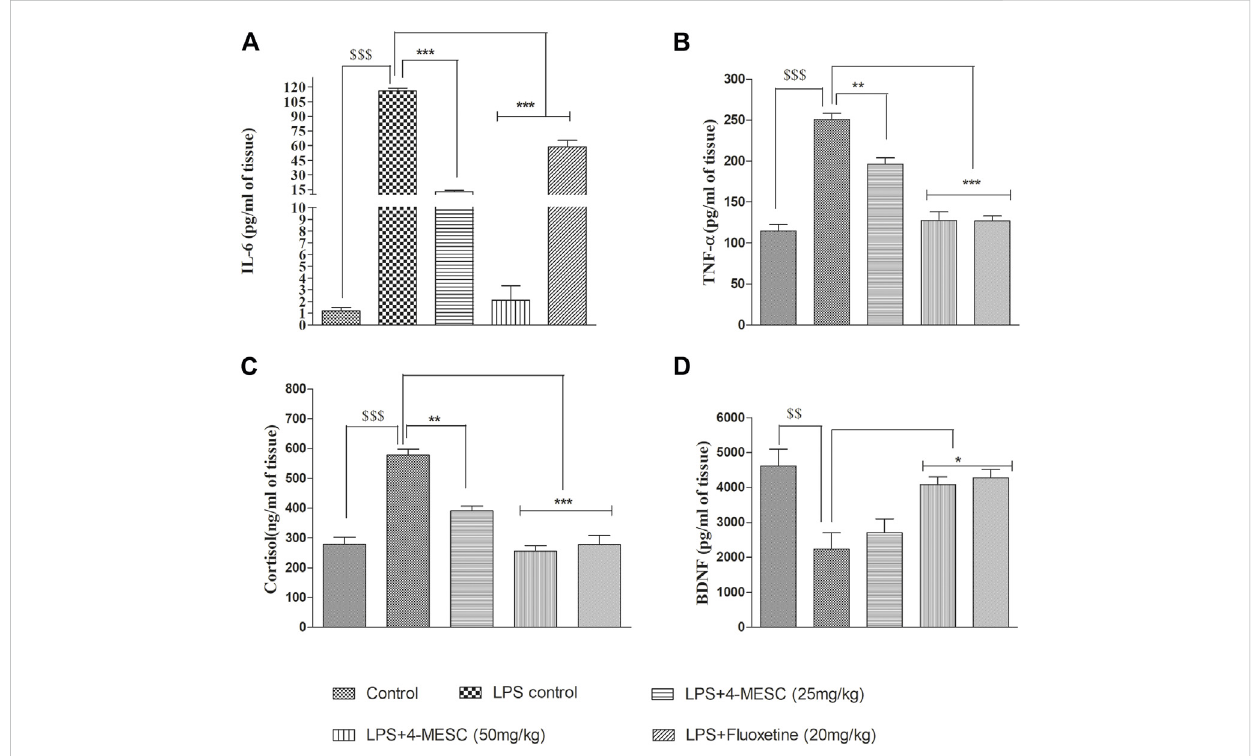
Effect of 4-MESC on pro-in fl ammatory cytokines. (A) Estimation of the IL-6 level through ELISA. (B) Determination of the level of TNF- α . (C) Neuroprotection evaluation of 4-MESC by estimation of BDNF using ELISA. (D) Cortisol level estimation. Data were represented as mean ± SD and * p